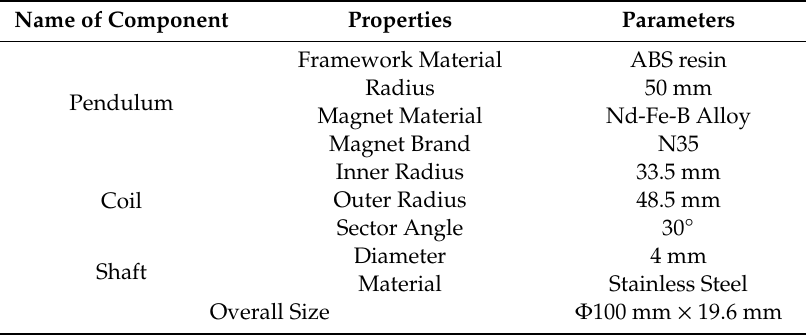
Figure 5. ( a ) Photo of the test platform; ( b ) root-mean-square and maximum output power results of the prototype; ( c ) output voltage waveform under 1.5 Hz vibration; ( d ) output voltage waveform under 2.0 Hz vibration; ( e ) output voltage waveform under 2.5 Hz vibration; ( f ) output voltage waveform under 3.0 Hz vibration. Table 1. Design parameters of the